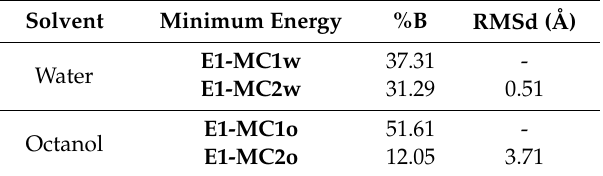
Table 2. %B and RMSd values of the most probable energy minima for E1, obtained after MC simulations conducted both solvents. RMSd values (Å) are calculated on the heavy atoms of E1 compared to the global energy minima ( E1-MC1w and E1-MC1o